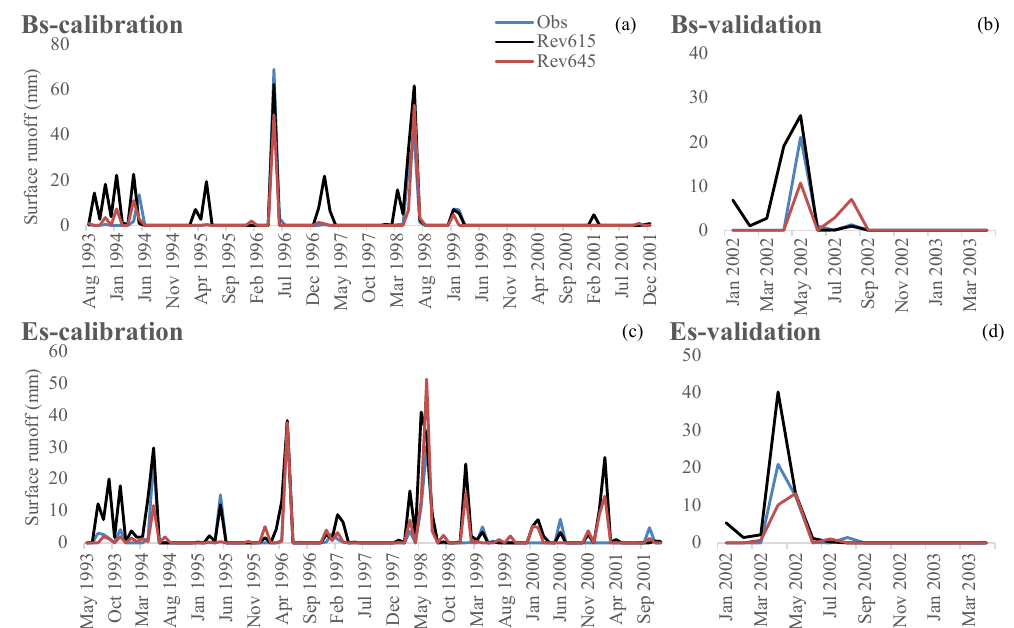
Figure 4. Calibration and validation results for monthly surface runoff at sites Bs (a, b) and Es (c, d) . Obs and Revs. 615 and 645 represent Observed and revisions 615 and 645,